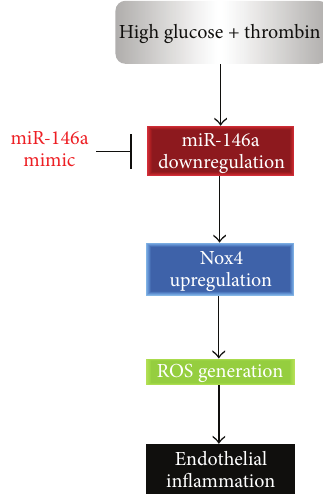
Figure 7: The proposed role of miR-146a in regulating HG/throm- bin-induced endothelial